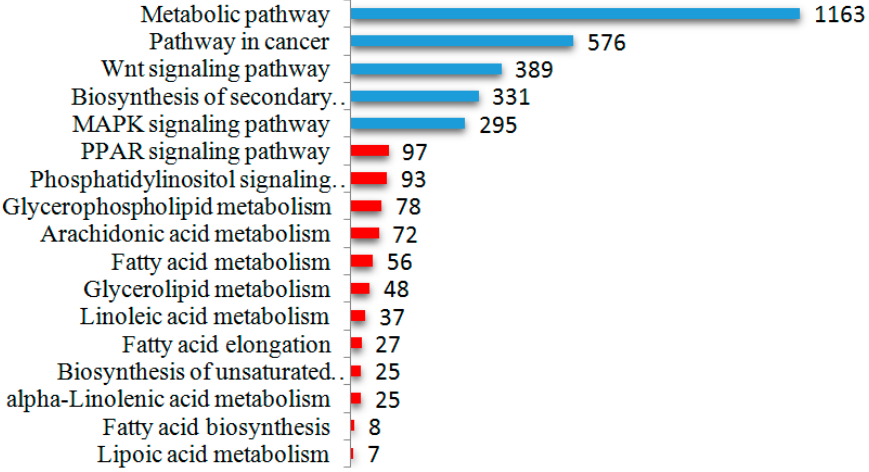
Figure 3. The number of miRNA predicted target genes mapped by pathway. Blue column: the significantly enriched pathway of target genes. Pink column: the annotated pathway related to the lipid